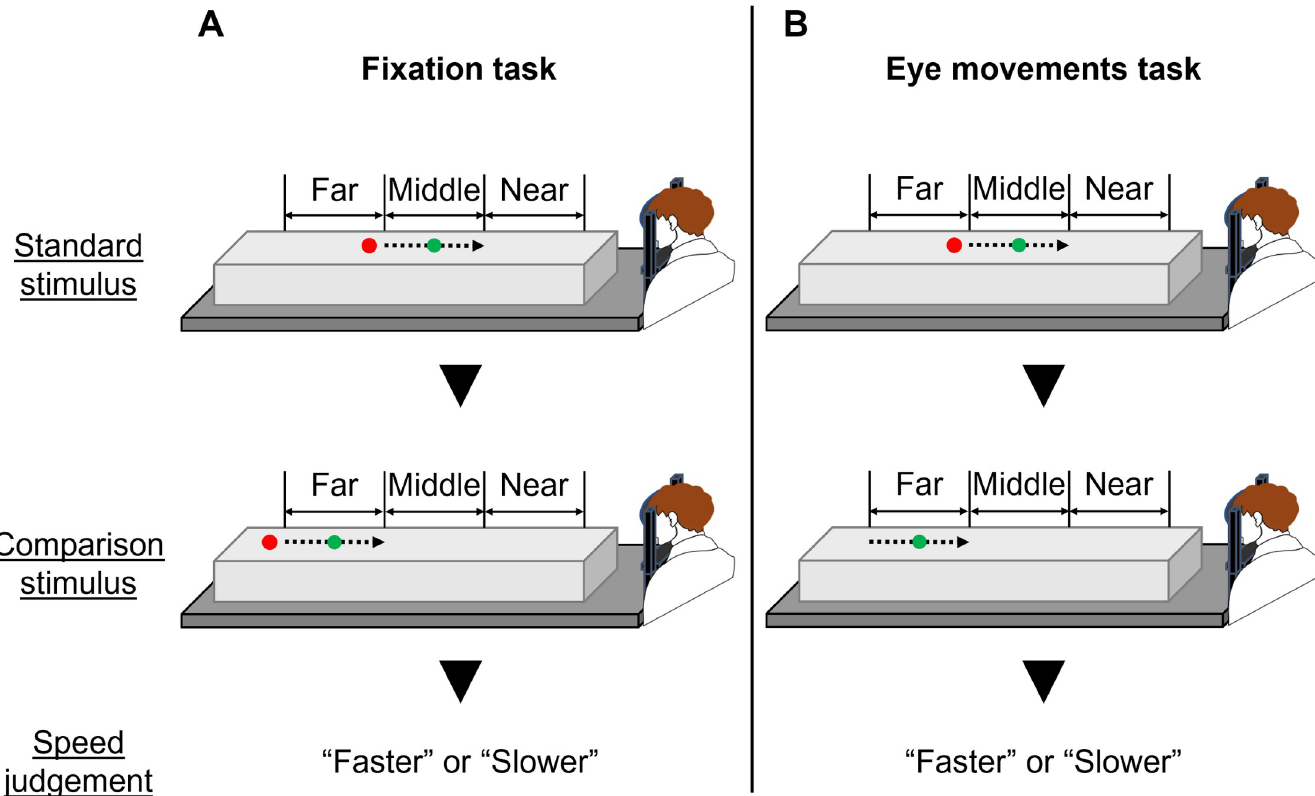
Fig 7. A two-alternative forced-choice paradigm. Fixation task (A): a green circle (visual target) moved from far to near at constant velocity in the real world and participants kept their eyes on the red circle (fixation point) in both standard and comparison stimuli. Eye movements task (B): a visual target moved from far to near at constant velocity in the real world, and participants kept their eyes on the fixation point in the standard stimulus and pursued the target with their eyes in the comparison stimulus. For both speed perception tasks, the participants compared the target speed between the standard and comparison stimuli.